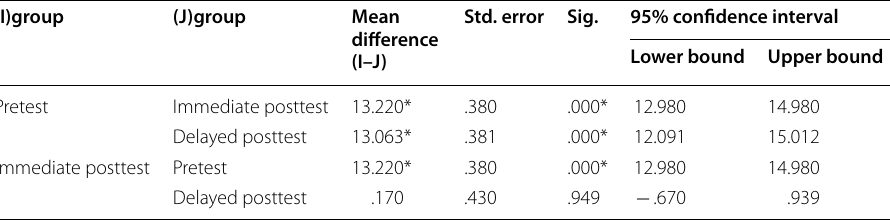
*Significant at the .05 level (2‑tailed)